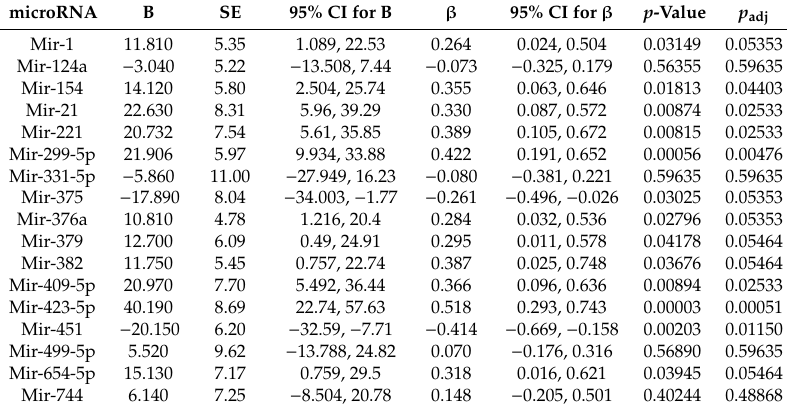
Table 2. Associations between microRNAs and NT-proBNP concentration.